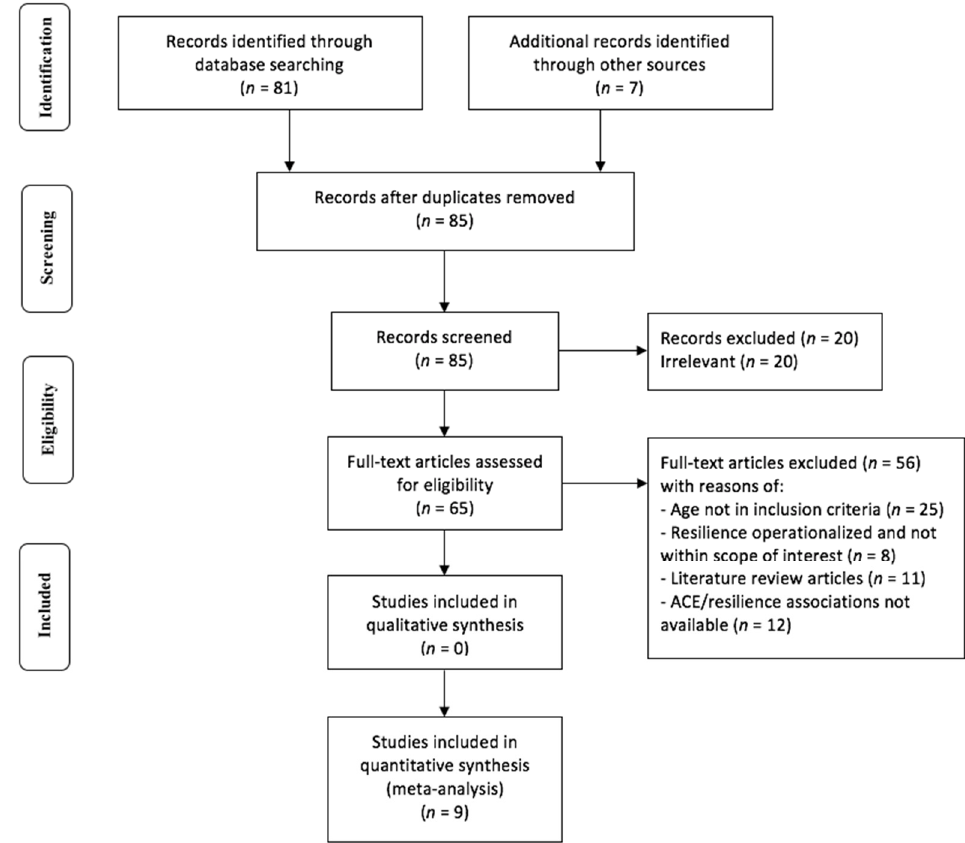
Figure 1. PRISMA flow chart illustrating search strategy. Table 1. Characteristics of the included studies.